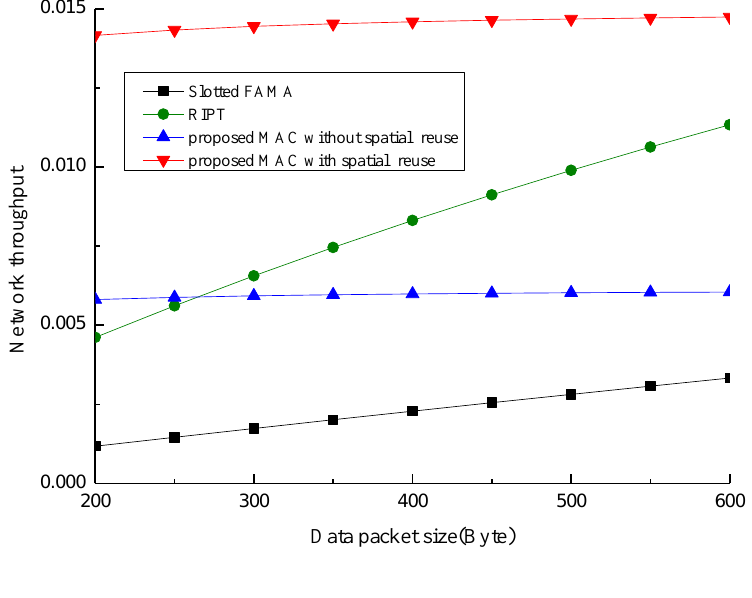
Figure 13. The impact of the data packet size on the network